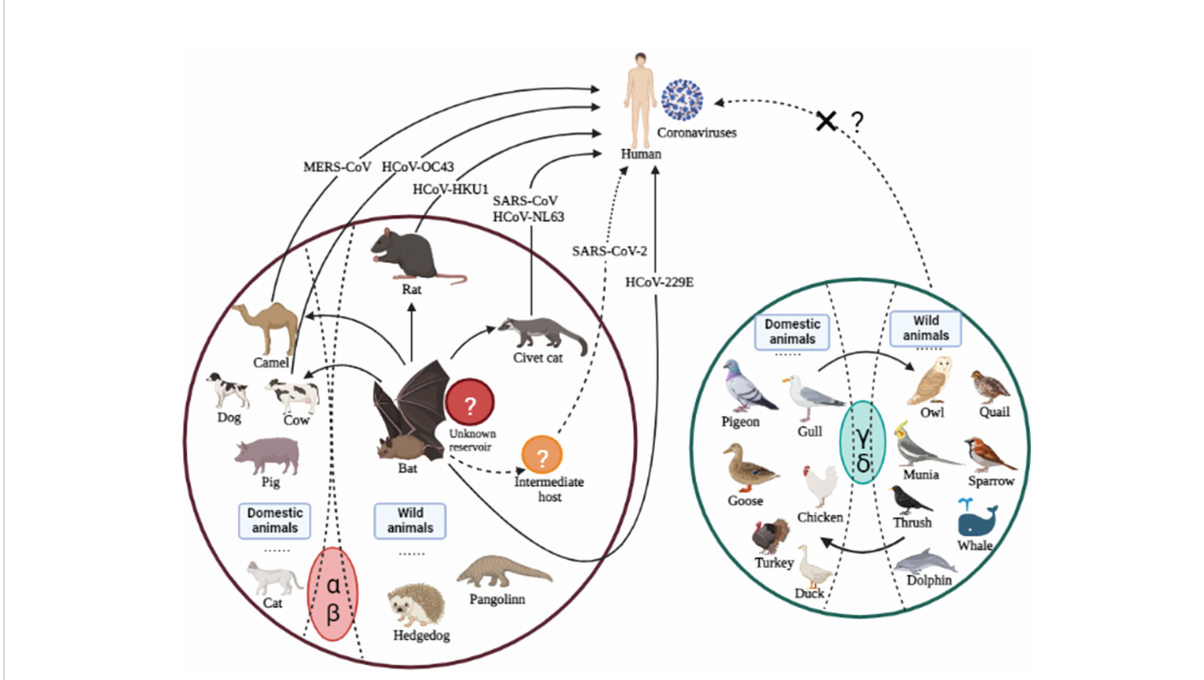
FIGURE 2 Cross-species transmission of CoVs is common among various animals. The arrows indicate the direction of virus transmission. The transmission sources of seven CoVs (all belonging to genera a and b ) infecting humans are depicted are intragenus mutual transmission. There have been no reports of human infections with genera g or d , which calls for additional research in the